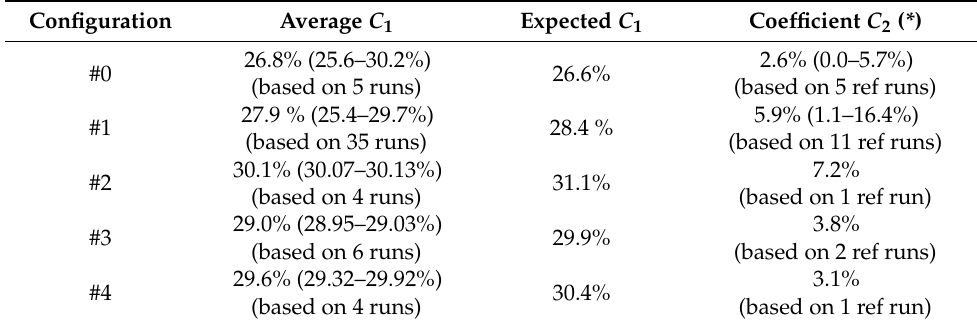
Table 4. Results synthesis of the average coefficients C 1 and C 2